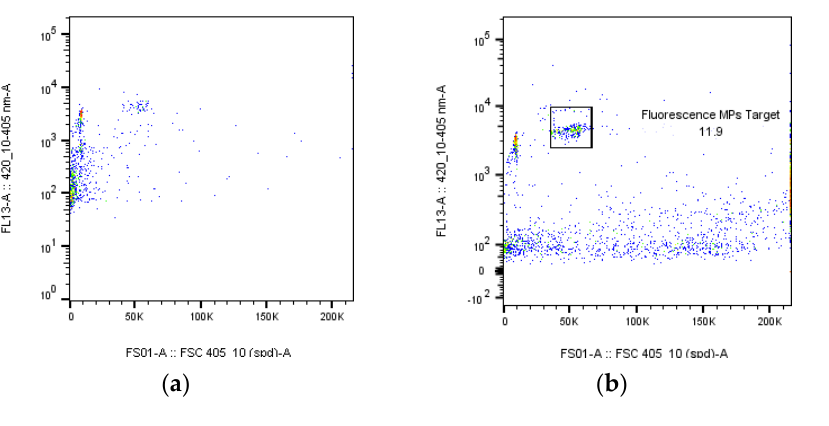
Figure 9. Flow cytometric analysis of ( a ) the method blank; ( b ) environmental seawater sample collected in Tsuen Wan West spiked with 8000 particles L − 1 self-fluorescence PS (1 µm); and ( c ) gated plot of environmental seawater sample in ( b ).